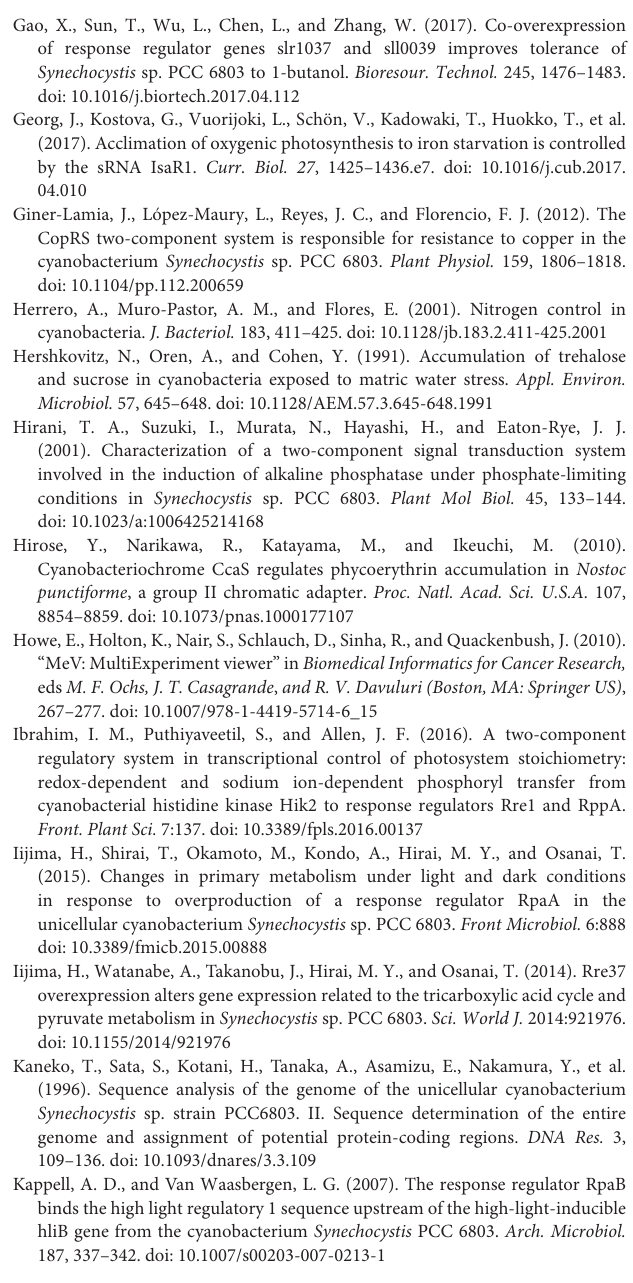
Figure S1 | Growth curves for 7 most-regulated mutants compared with the wile type. Figure S2 | Pathway view of metabolite changes in 1 slr2024 , differential regulated metabolites were represented by color, red for down-regulated and green for up-regulated metabolites.